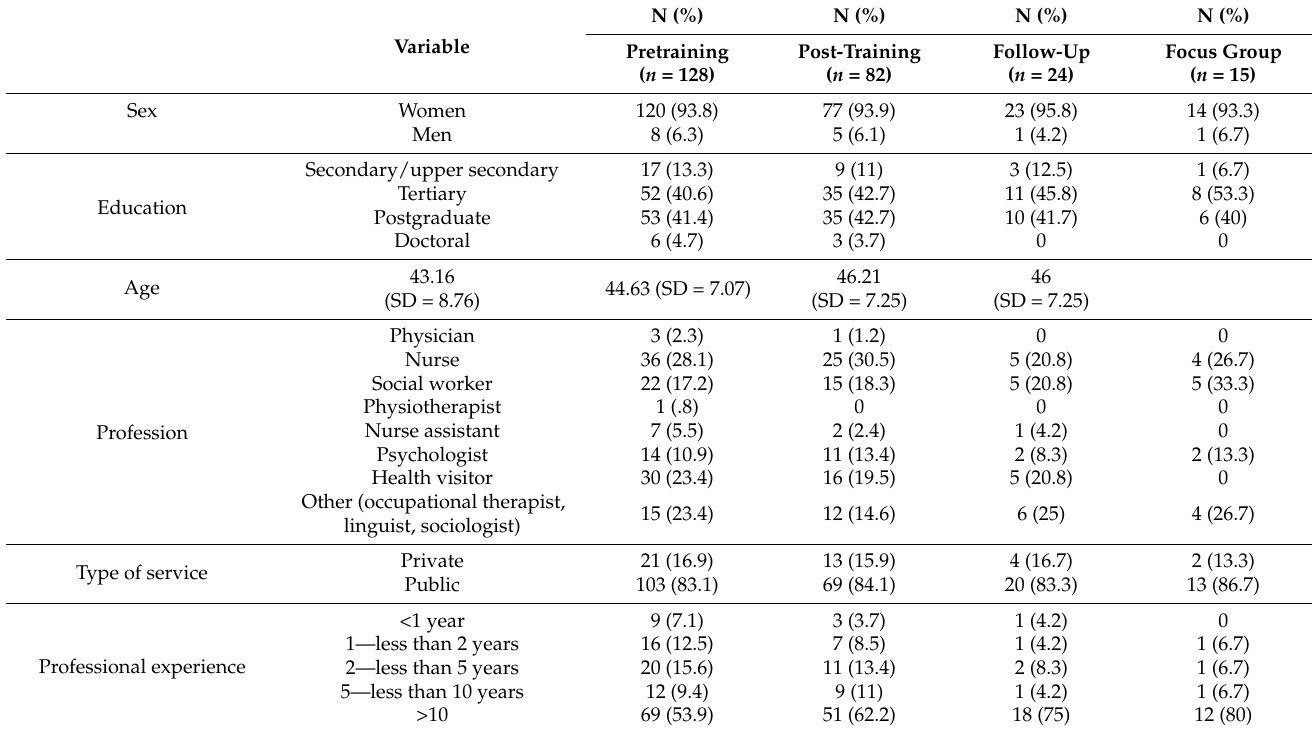
Table 2. Descriptive characteristics of the participants.